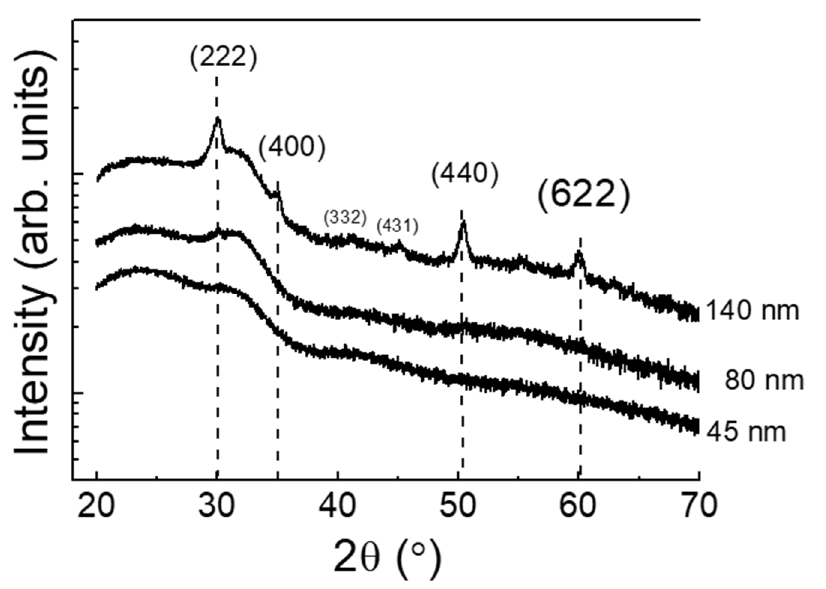
Figure 1. GI ‐ XRD scans of ITO thin films as function of the thickness, deposited at soft sputtering conditions.